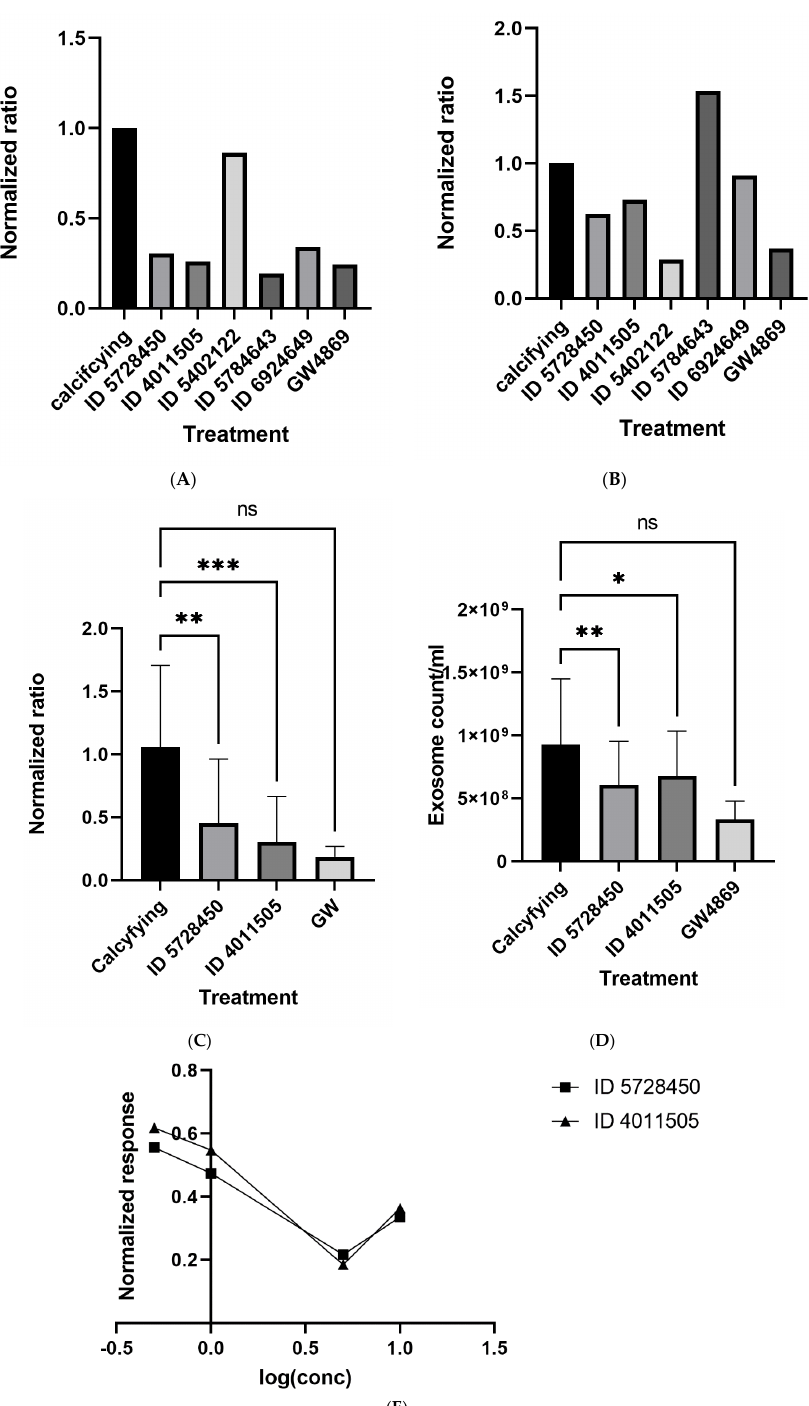
Figure 6. nSMase2 inhibitors, ID 5728450 and ID 4011505, reduce calcification and EV release in VSMCs. VSMCs were treated with the test compounds in media with 0.5% FBS and 5.4 mM Ca 2+ for 48 h. ( A ) Calcification assay with VSMCs treated with 5 µM of each compound. Ca 2+ concentrations (µg/µL) were normalized to protein concentrations (µg/µL). ( B ) EV quantification using NTA. VSMCs were treated with 5 µM of each compound. ( C ) Calcification assay with VSMCs treated with 5 µM of each compound. Ca 2+ concentrations (µg/µL) were normalized to protein concentrations (µg/µL); p = 0.0060 (ID 572845) and p = 0.0005 (ID 4011505) to calcifying control, p = 0.0004 between columns. ( D ) EV quantification using NTA. VSMCs were treated with 5 µM of each compound; p = 0.0189 (ID 4011505) and (ID 5728450) p = 0.0030 to calcifying control, p = 0.0073 between columns. ( E ) Calcification assay with VSMCs treated with increasing concentrations of inhibitors. Dose-re- sponse calculations indicated IC 50 = 1.732 µM for ID 5728450, and IC 50 = 1.910 µM for ID 4011505 with calcification as a readout. Statistical significance was tested using mixed effects analysis (REML) using GraphPad Prism 9.0.2; * p < 0.05, ** p < 0.01, *** p < 0.001.